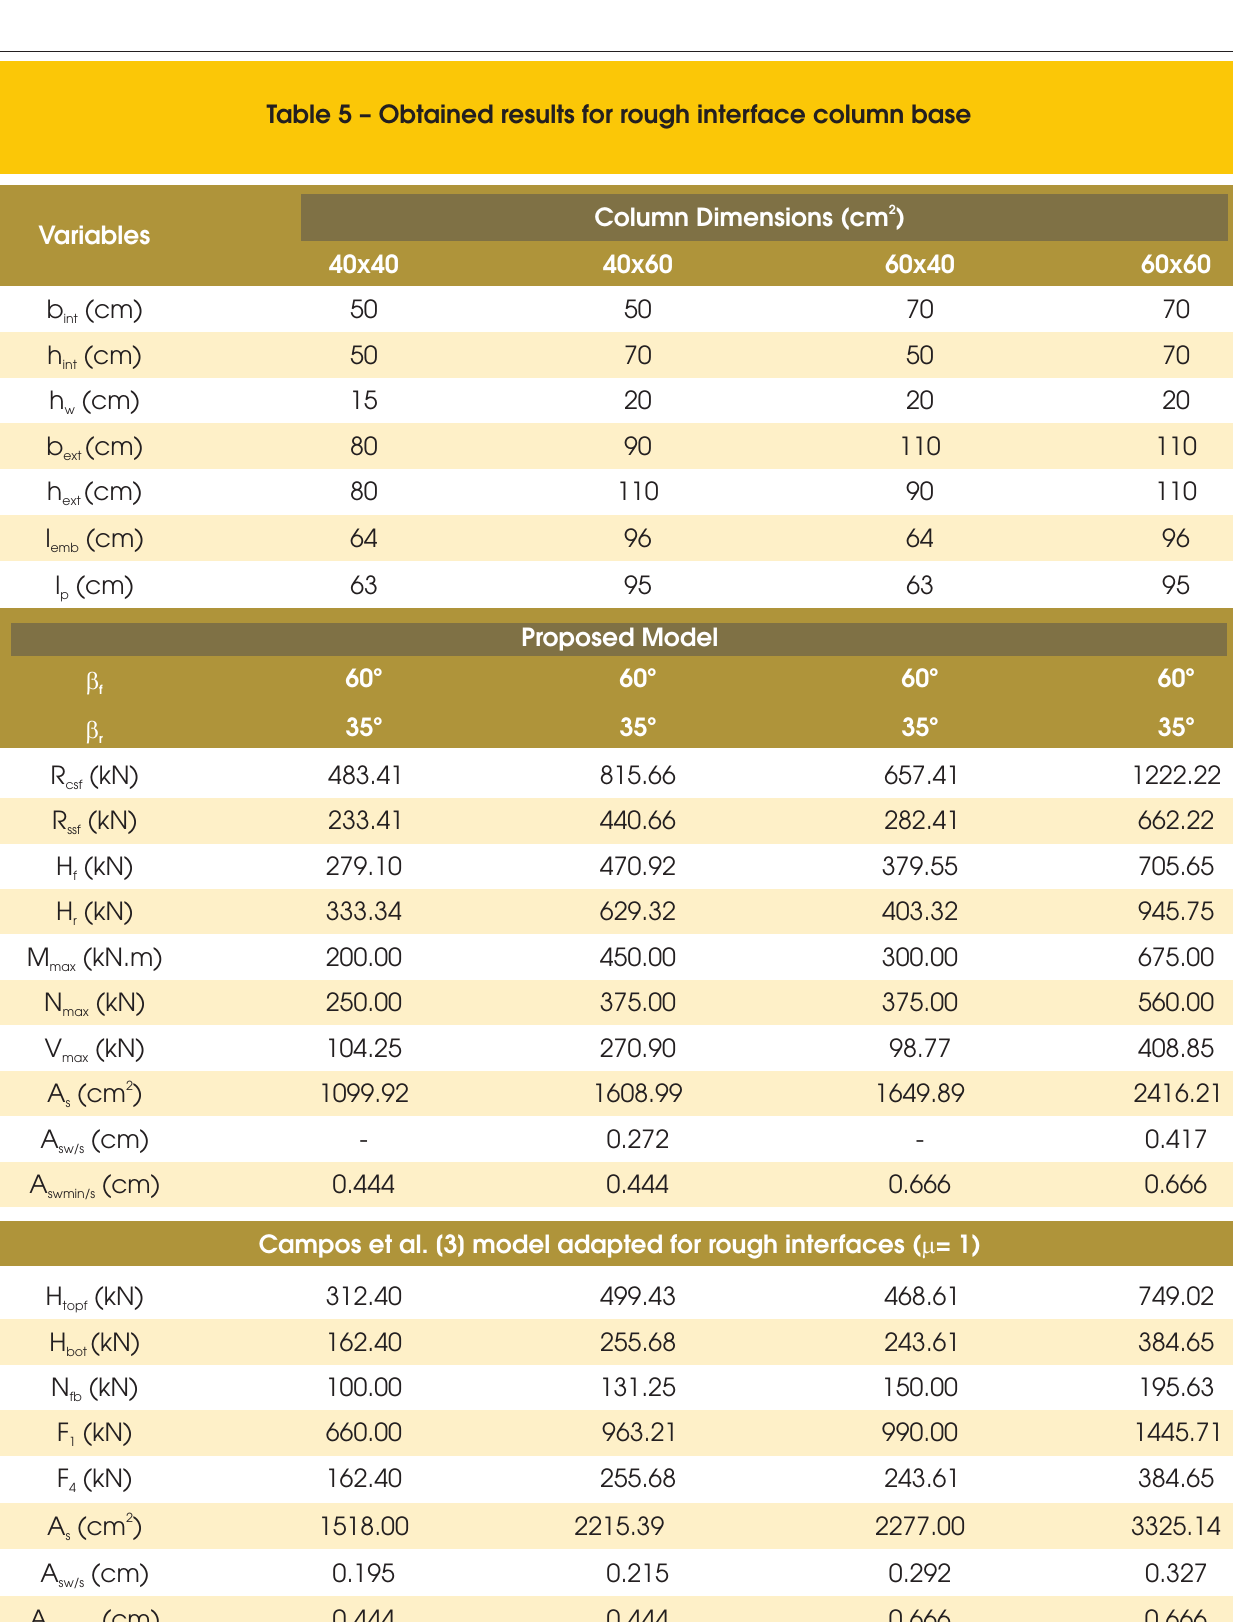
Table 5 – Obtained results for rough interface column